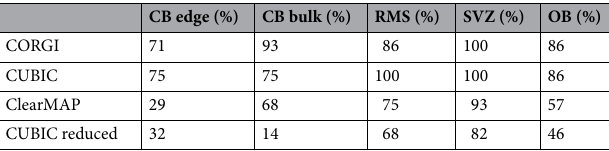
Table 2. Registration quality.